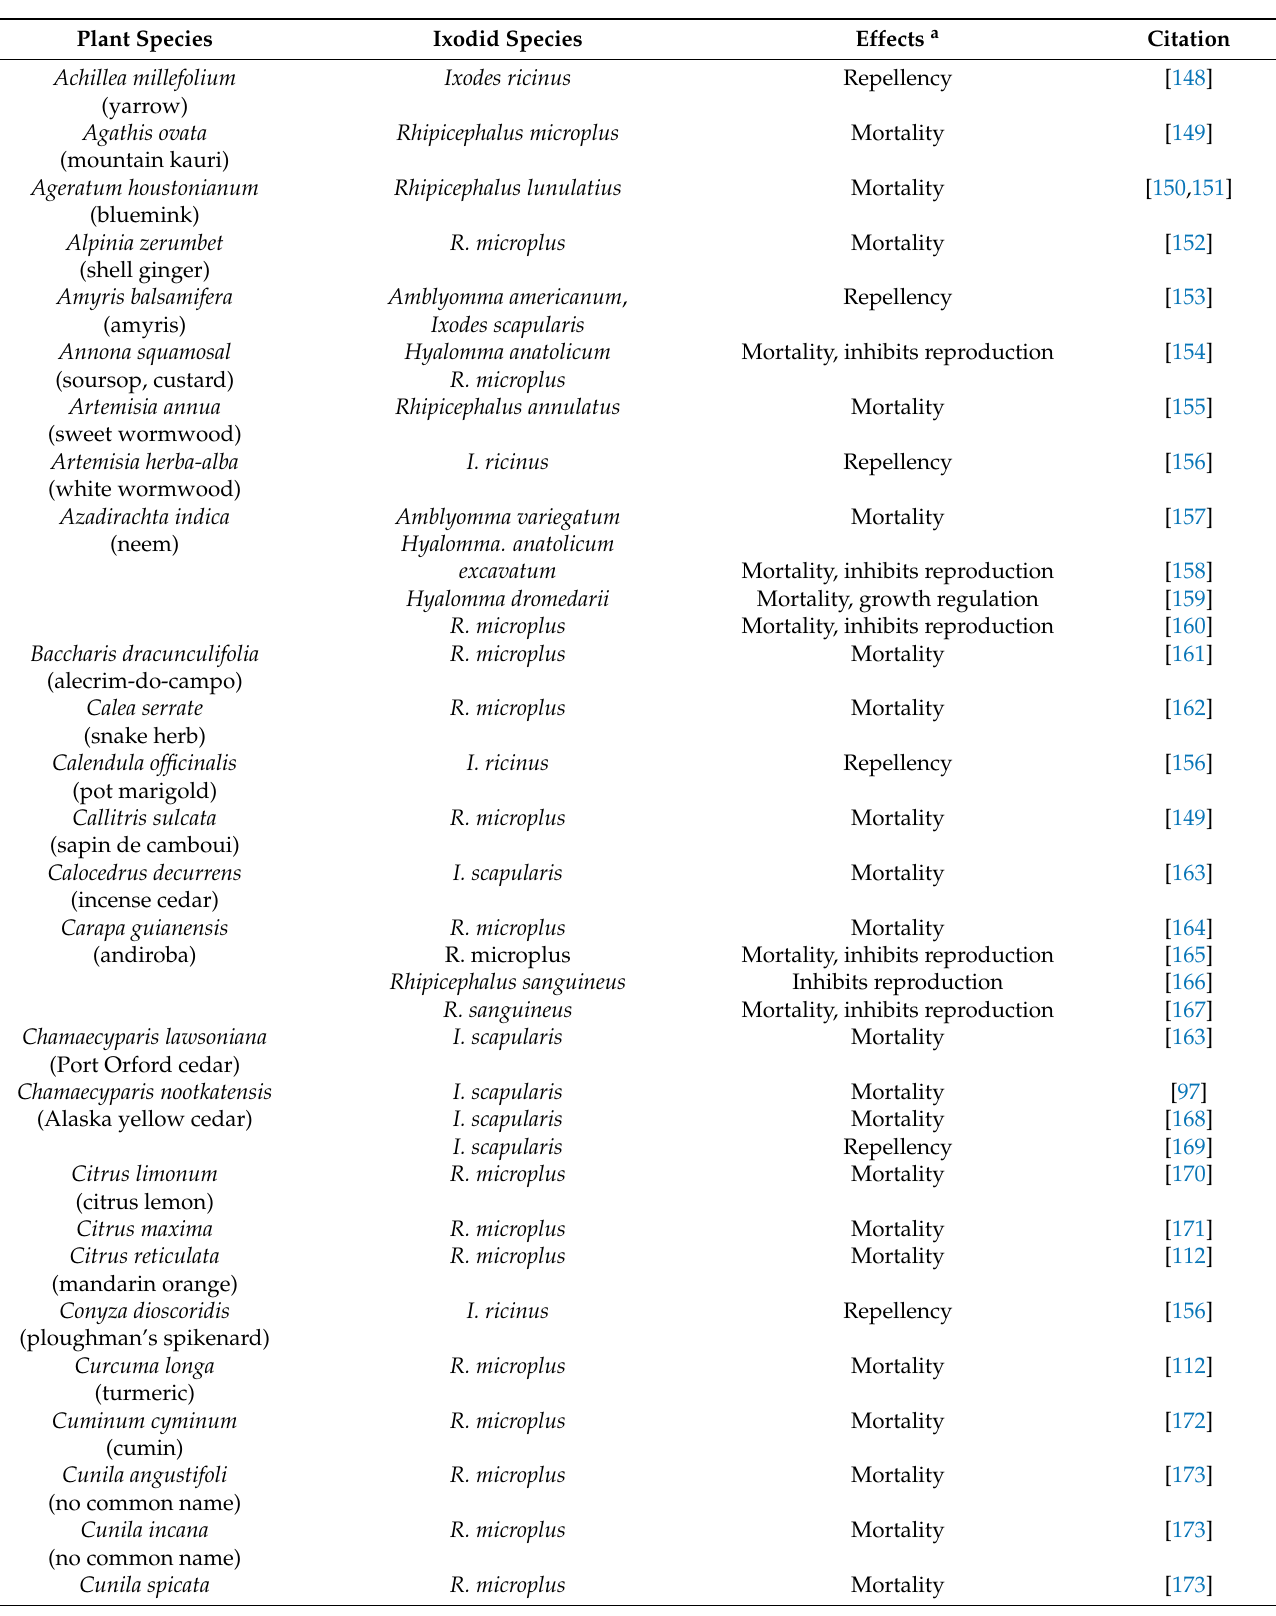
Table 2. Selected studies that report lethal and sublethal effects of essential oils (solvents, exposure times, experimental conditions, and other parameters are not